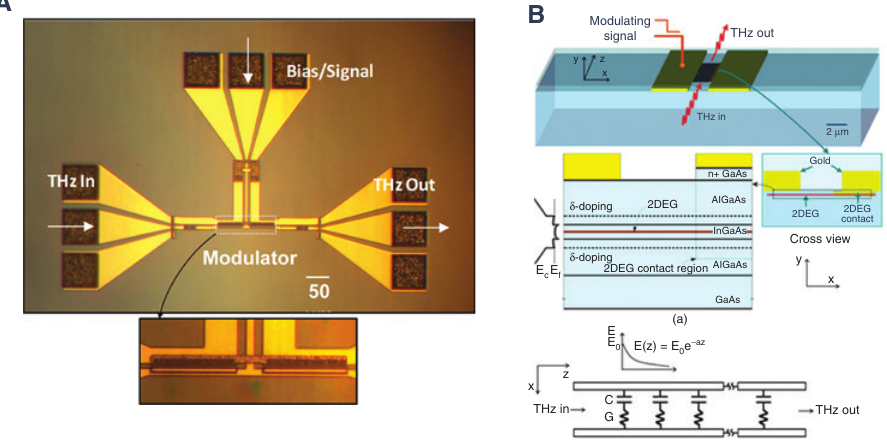
Figure 8: (A) Optical micrograph image of the real device. (B) Schematic of the THz modulator device based on slot waveguide and 2DEG; material composition and equivalent electronic circuit are reported as well. Reprinted and adapted from Singh and Sonkusale